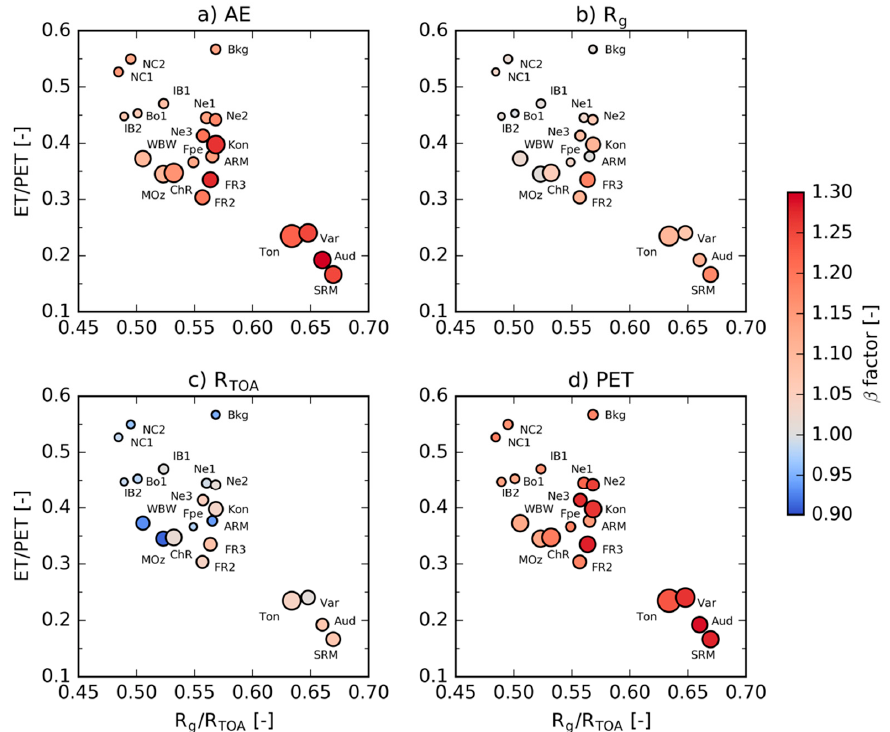
Figure 5. Results in Figures 4 and 5 were based on clear-sky observations at 13:00 with no restrictions on sky conditions before or after 13:00 (i.e., part of the day could be cloudy). For all scaling methods, we found that β factors tend to increase when the ET/PET ratio decreases or when the R G /R TOA ratio increases. For example, β AE factors were around 1.0–1.1 for most of the sites located in temperate regions while varied between 1.2 and 1.3 for sites located in semi-arid regions. Comparing the four scaling methods, β AE factors varied from 1.06 to 1.31, β RG from 0.99 to 1.18, β RTOA from 0.91 to 1.08 and β PET from 1.12 to 1.29 depending on sites (Table A1 in Appendix A). The scaling method based on R TOA overestimated daytime ET at some of the sites and we found associated β RTOA factors lower than 1 (Figure 4).